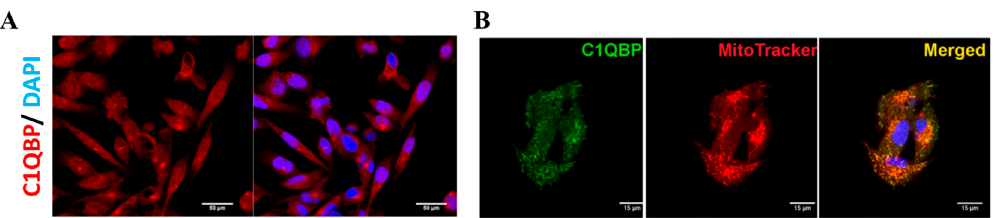
Figure 1. ( A ) Confocal microscopy showing mainly cytoplasmic C1QBP staining and also nuclear staining in a fraction of MDA-MB-231 cells. Scale bar: 50 μ m. ( B ) Merged panel (yellow) depicts the co-localization of C1QBP (green) with MitoTracker ® Red CMXRos (red). Scale bar: 15 μ m.